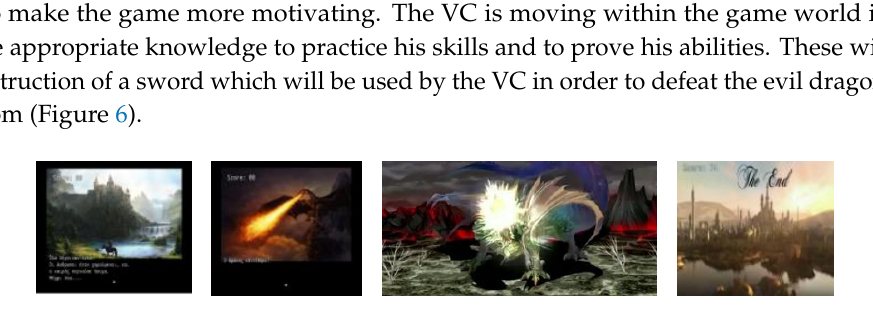
Figure 5. The blacksmith and the VC in the blacksmith’s shop. Figure 8. The blacksmith and the VC in the blacksmith’s shop. Figure 8. The blacksmith and the VC in the blacksmith’s shop.